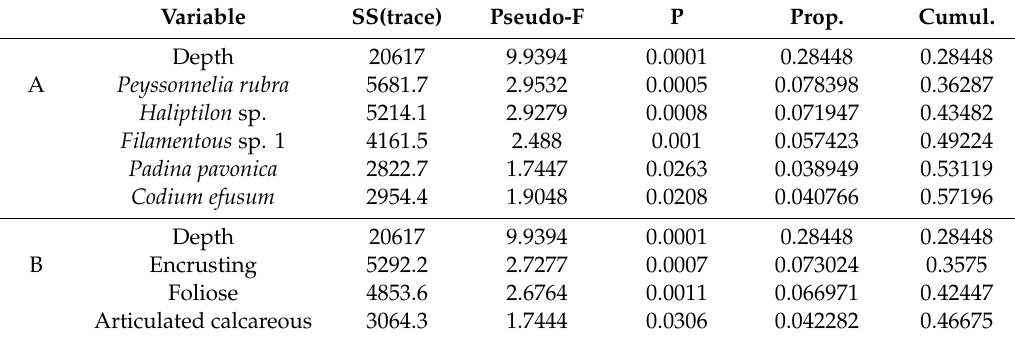
Table 3. Results of DISTLM-forward analysis. ( A ) Variables: percent coverage of each algal taxa (5% cut-o ff ), depth and orientation), ( B ) Variables: percent coverage of algal functional-morphological groups, depth and orientation). Only variables significantly contributing to explain variation of polychaete assemblages ( p < 0.05) are presented. Prop.: proportion of explained variation; Cumul.: cumulative proportion of explained